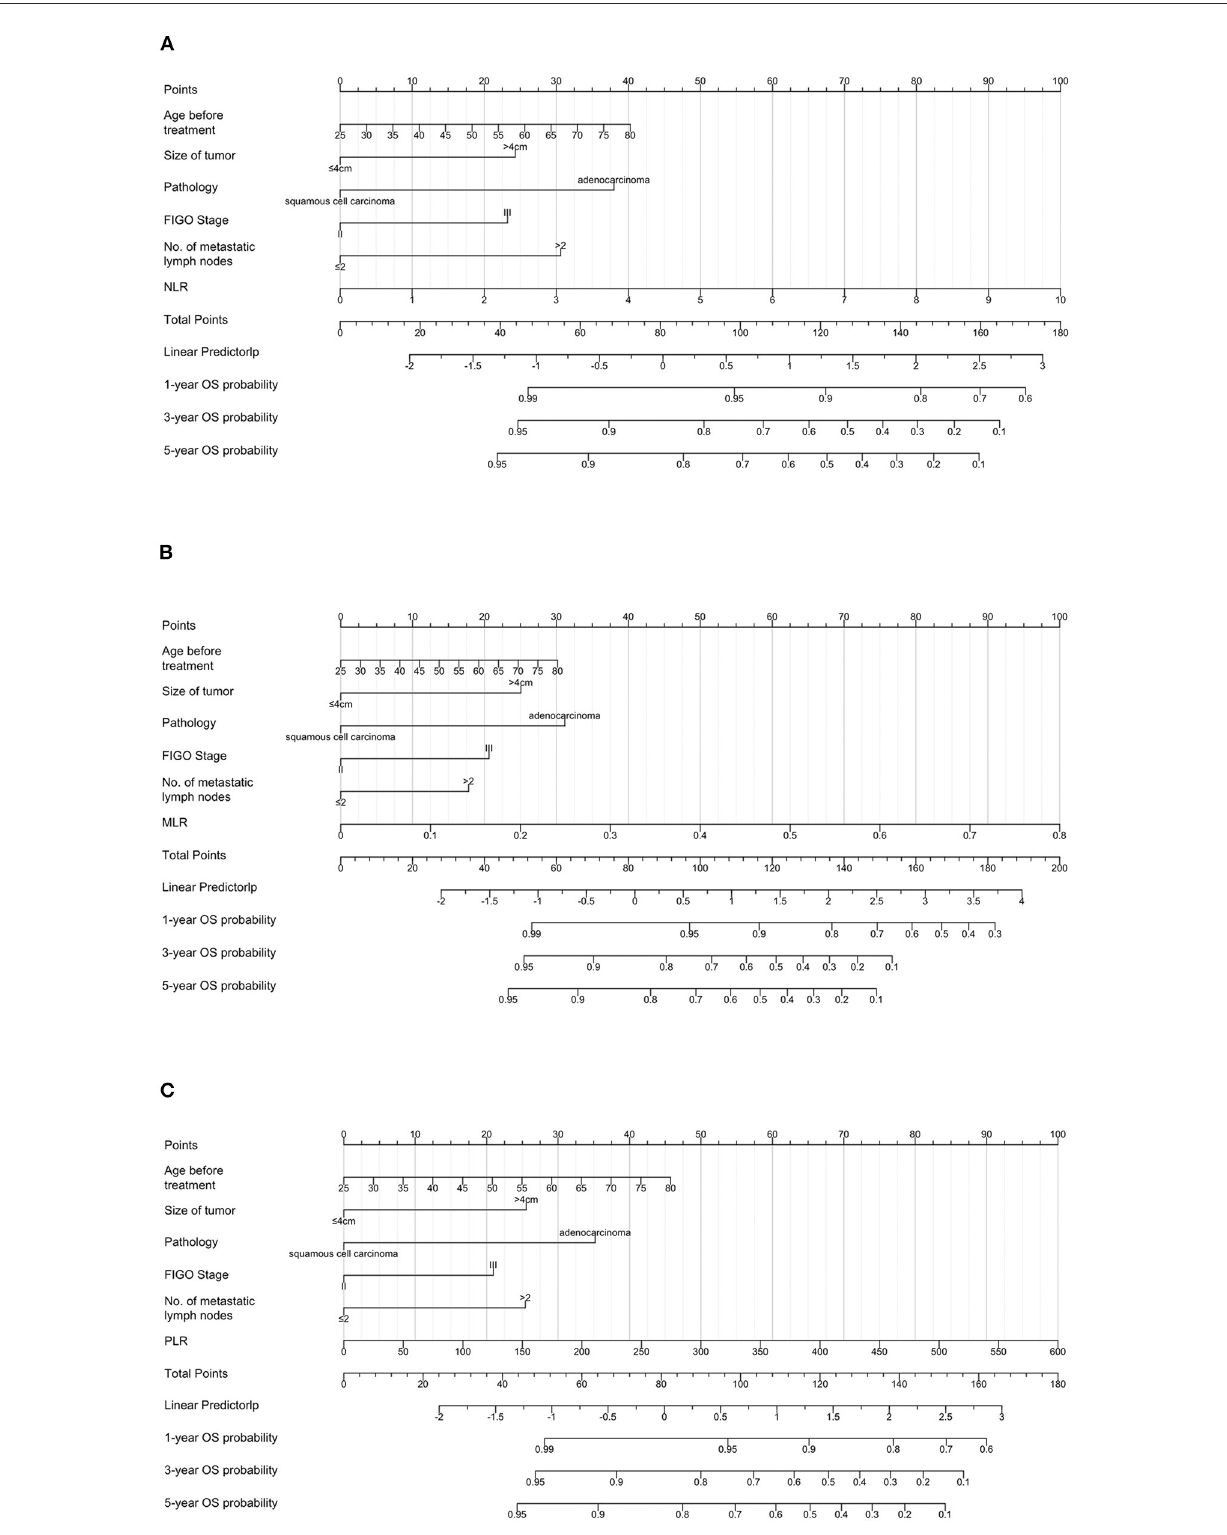
FIGURE8 Prognostic nomograms for overall survival prediction according to the neutrophil/lymphocyte ratio (NLR) (A) , monocyte/lymphocyte ratio (MLR) (B) , and platelet/lymphocyte ratio (PLR) (C) . Points were assigned for age before treatment, and for tumor size, histological type, stage, number of metastatic lymph nodes, and inflammatory indicators. The score of each predictor was determined by drawing a vertical line from the value to the score scale. The total score was summed up by the scores of these predictors, which correspond to overall survival